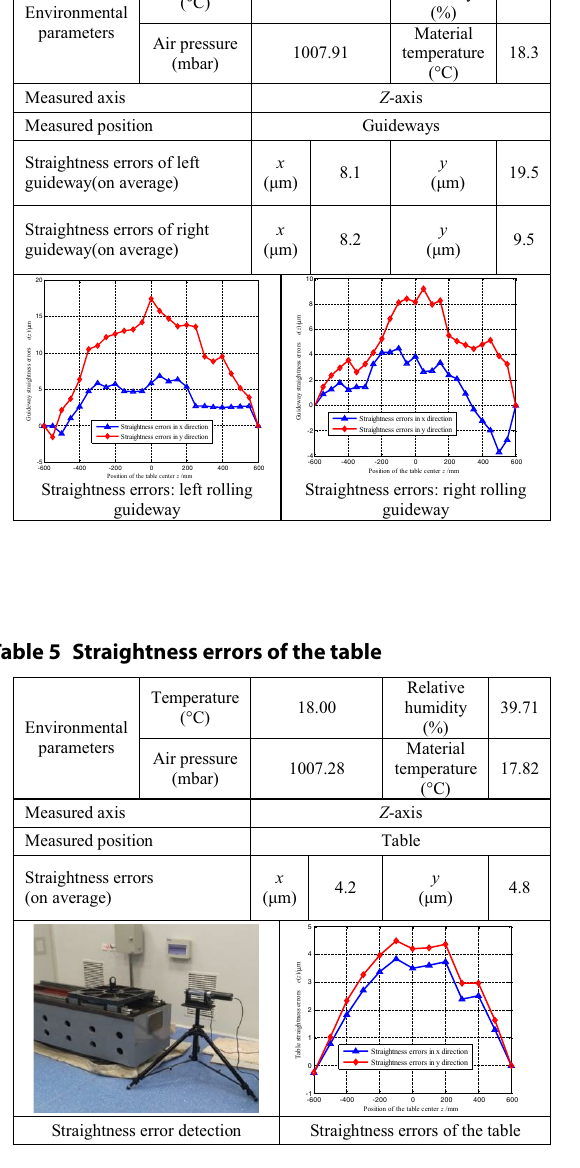
Straightness error detection Straightness errors of the table